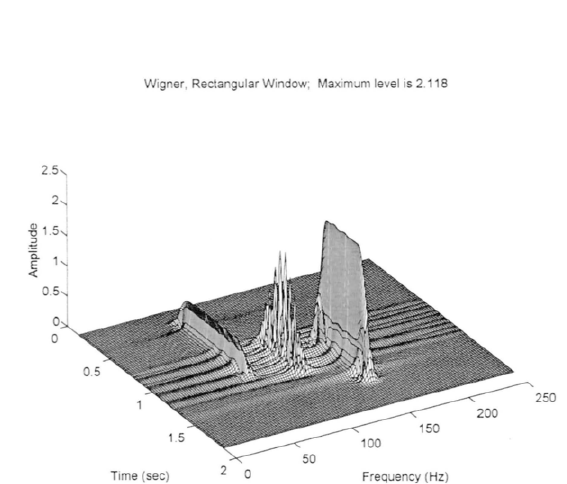
FIGURE 3 Pseudo-Wigner transform of Twosines with rectangular window.